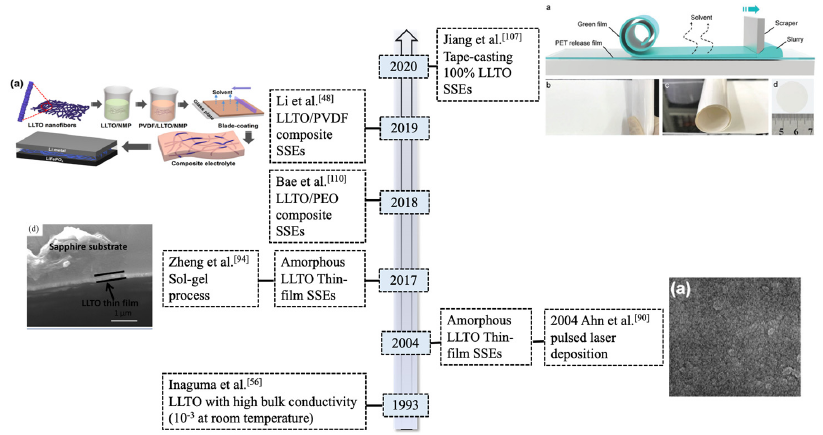
Figure 2. Timeline for the development of typical LLTO (La 2/3-x Li 3x TiO 3 ) solid-state electrolytes (SSEs) in lithium metal batteries. Table 1. Summary of electrochemical performance for selected LLTO SSEs in LBs.